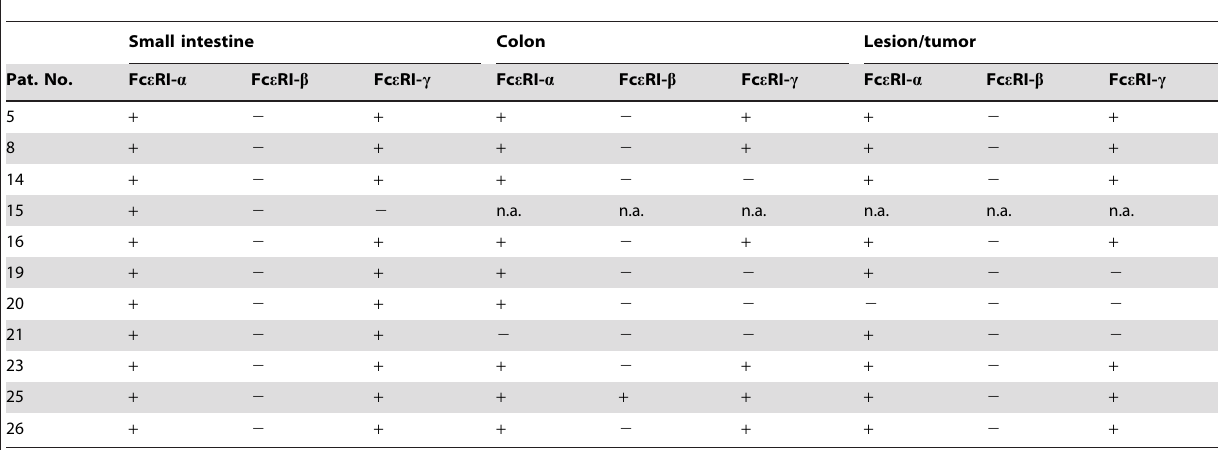
Table 2. Fc e RI b - and c -chain staining results in Fc e RI a -chain expressing intestinal tissue.